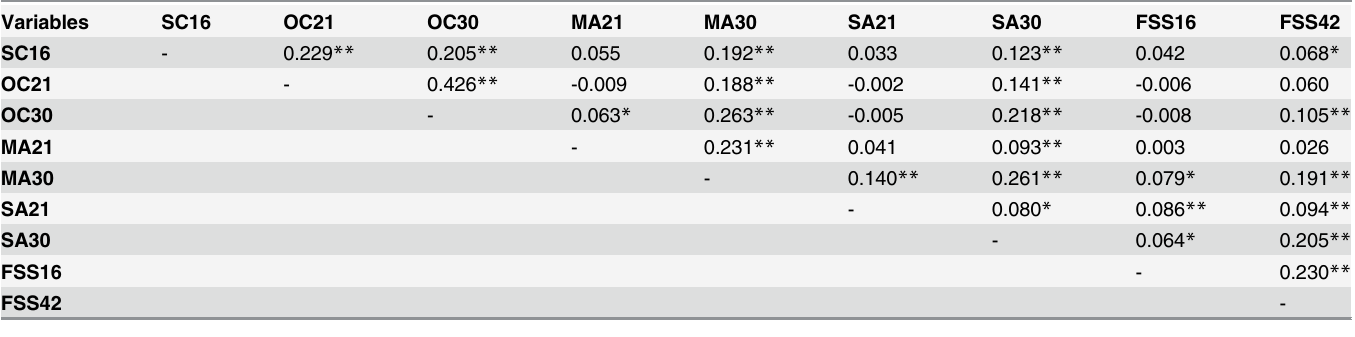
than half reported a low occupational class of their own (63%), while at age 30, this number had decreased to 43%. The sex stratified analysis (Table 1) revealed that social and material adversity as well as functional somatic symptoms at age 42 differed, where women presented more adversi- ties overall, as well as more functional somatic symptoms at age 42, compared to men. Table 2 presents zero-order correlation coefficients (Pearson ’ s r ) between all the variables. Cross-validation using Spearman ’ s rho yielded similar results. Although only marginally, an unfavorable socioeconomic environment at age 16 was positively correlated with functional somatic symptoms at age 42 ( r = 0.068), while both material and social adversities at age 30 Table 2. Pearson ’ s correlations for socioeconomic conditions (SC), occupational class (OC), material adversity (MA), social adversity (SA), and functional somatic symptoms (FSS) at four points in time — respondents aged 16, 21, 30 and 42.